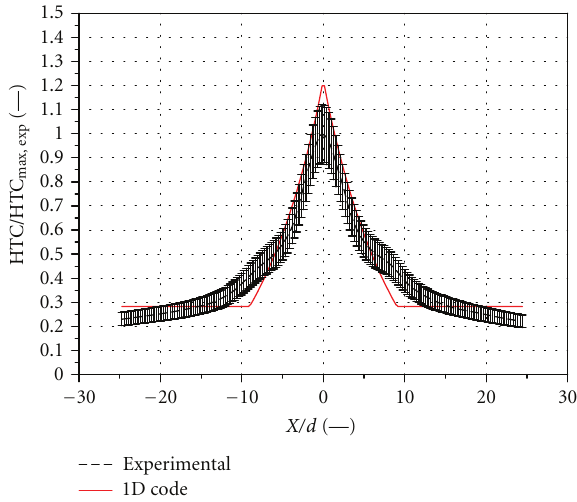
Figure 10: Heat transfer coe ffi cient distribution, central hole of the array, Geom 1 β = 1 . 05 (experimental data from Facchini et al. [14]).